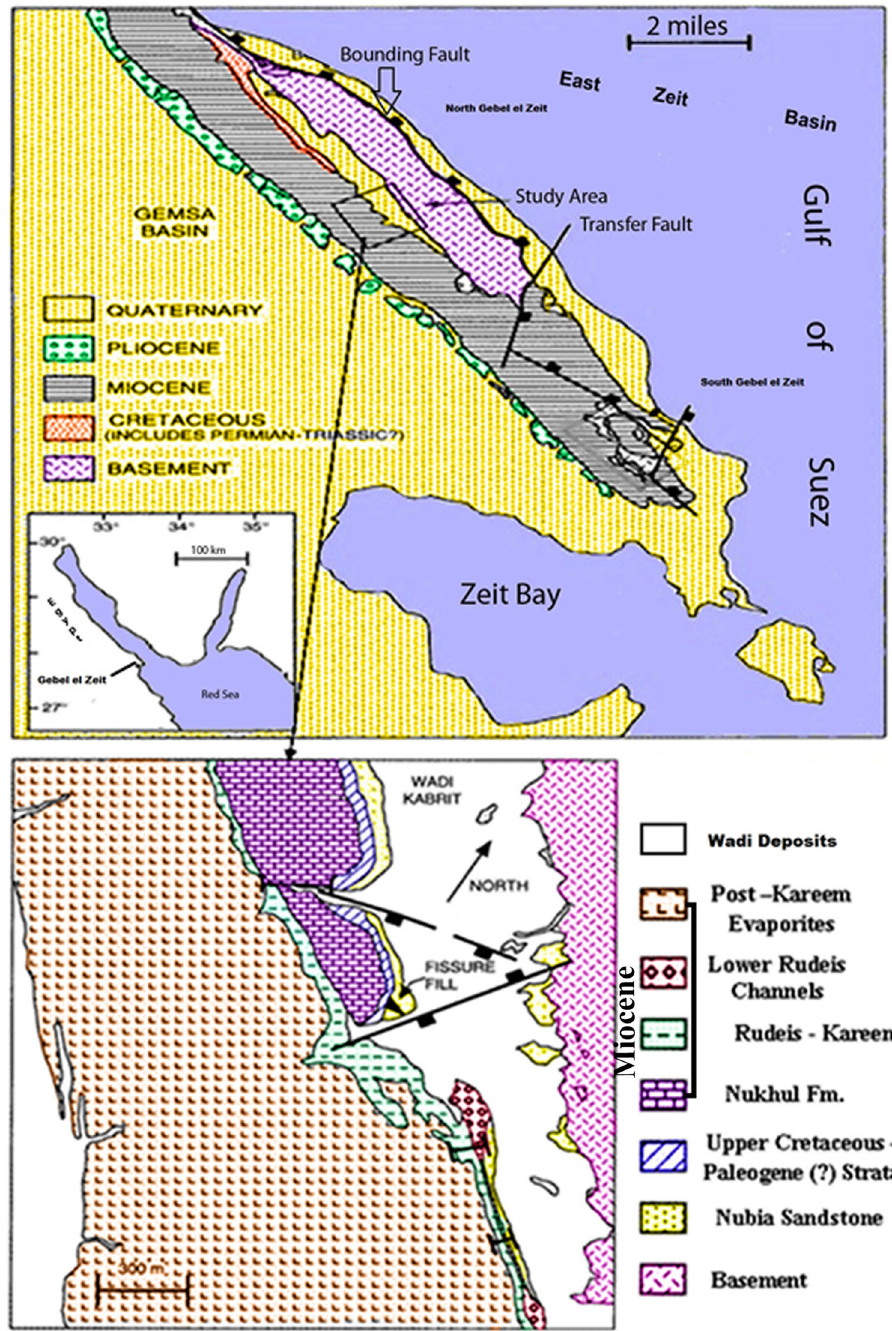
Fig. 1 Geologic map of the Gulf of Suez showing basement, pre-Miocene, Miocene outcrops, and detailed geologic map of North Gebel